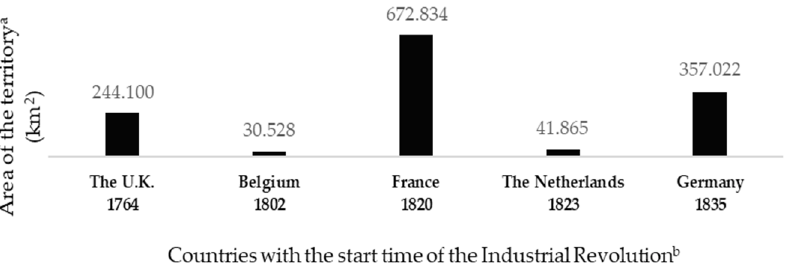
Figure 13. Comparative analysis with main industrial countries around Belgium ( a . National data derived from national statistical records, see Appendix A Table A3. b . The date of beginning from Western European countries is based on the data derived from Hudson, Kenneth (1979).).